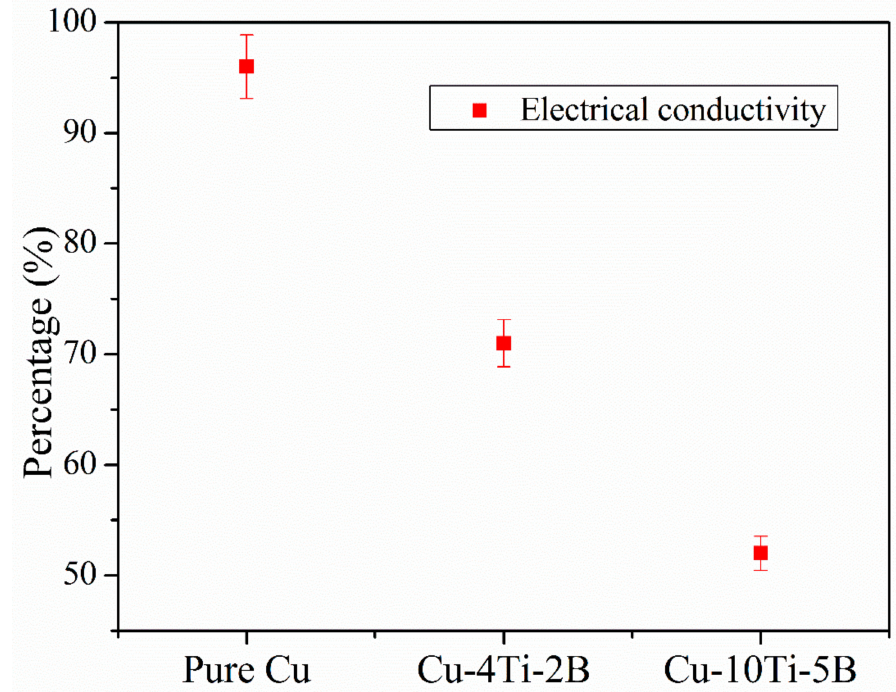
Figure 13. Electrical conductivity of pure Cu with two types of